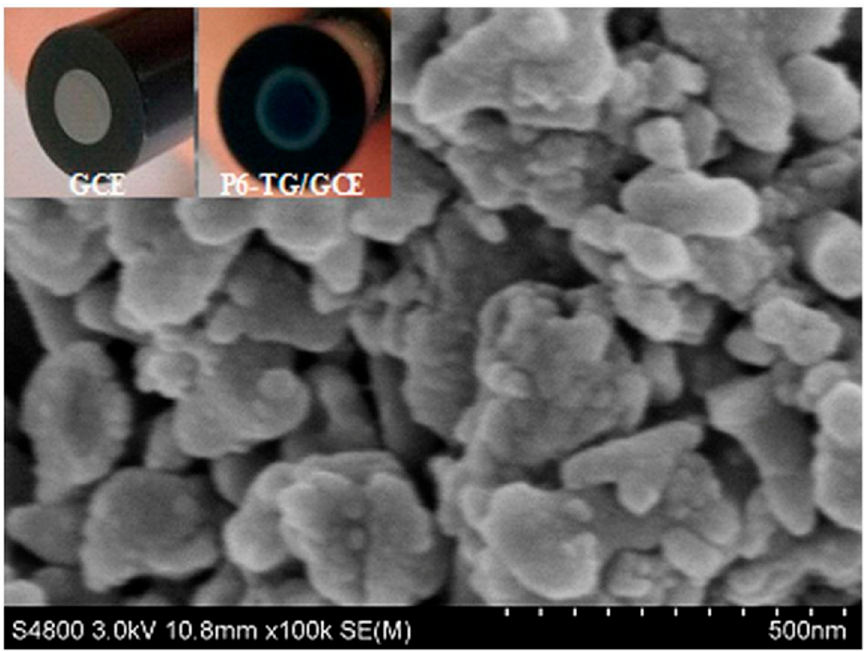
Figure 14. Micrograph of poly (6-thioguanine) film (P6-TG) deposited over glassy carbon elec- trode. Reproduced with permission from [152]. Copyright 2015 Elsevier B.V. Reproduced with permission from [152]. Copyright 2015 Elsevier